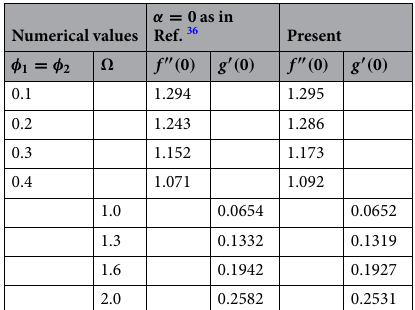
Numerical values